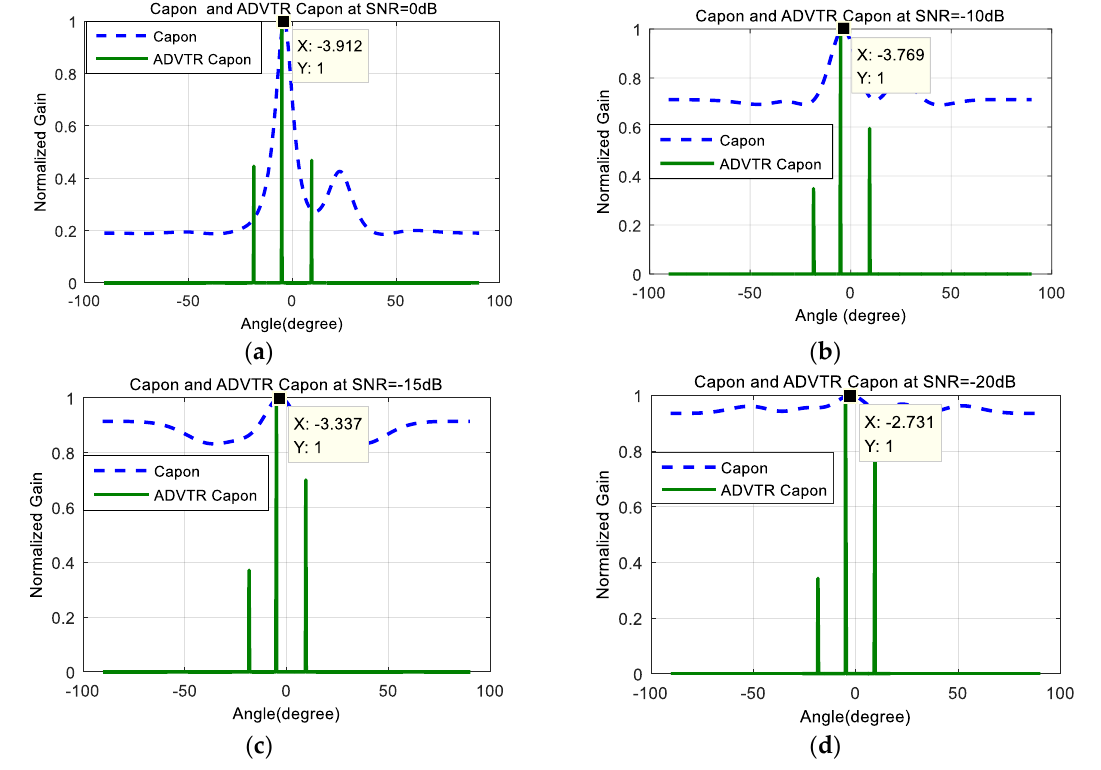
Figure 6. Capon estimator and ADVTR Capon estimator at θ = − 5 ◦ . ( a ) SNR = 0 dB; ( b ) SNR = − 10 dB; ( c ) SNR = − 15 dB; ( d ) SNR = − 20 dB.